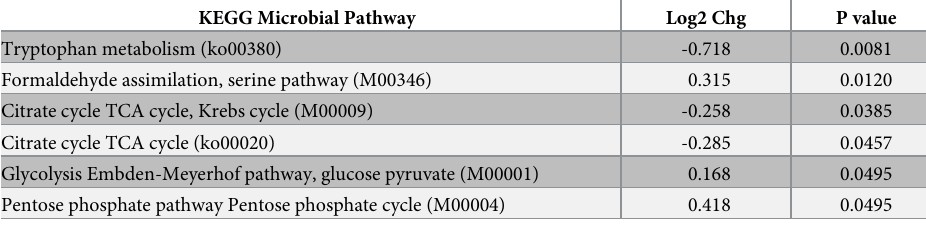
Table 5. Changes in functionally-defined metabolic pathways in early stage